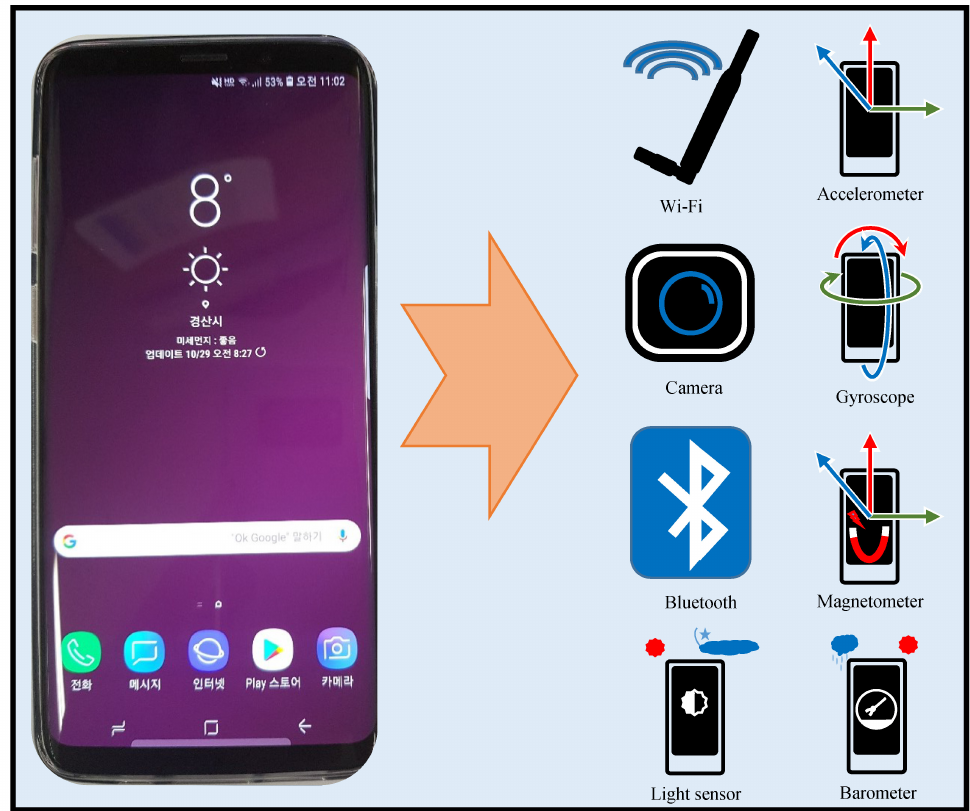
Figure 1. Smartphone sensors embedded in modern